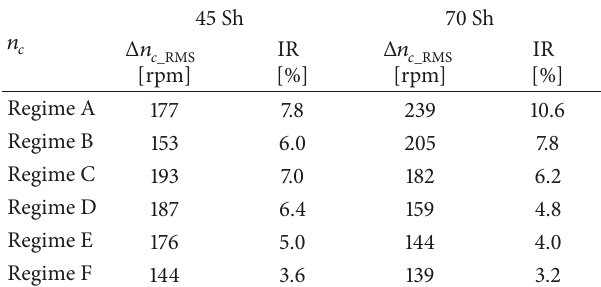
Table 6: 70 Sh configuration. (a) List of experimental resonances. (b) List of numerical (FE) natural frequencies, in percentage of 𝑓 max . (a) 70Sh: experimental